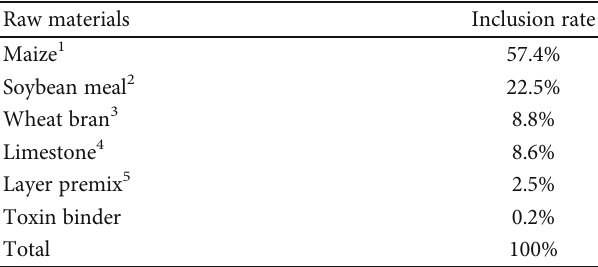
Table 2: Ingredients (% air-dry basis) of the feed. Raw